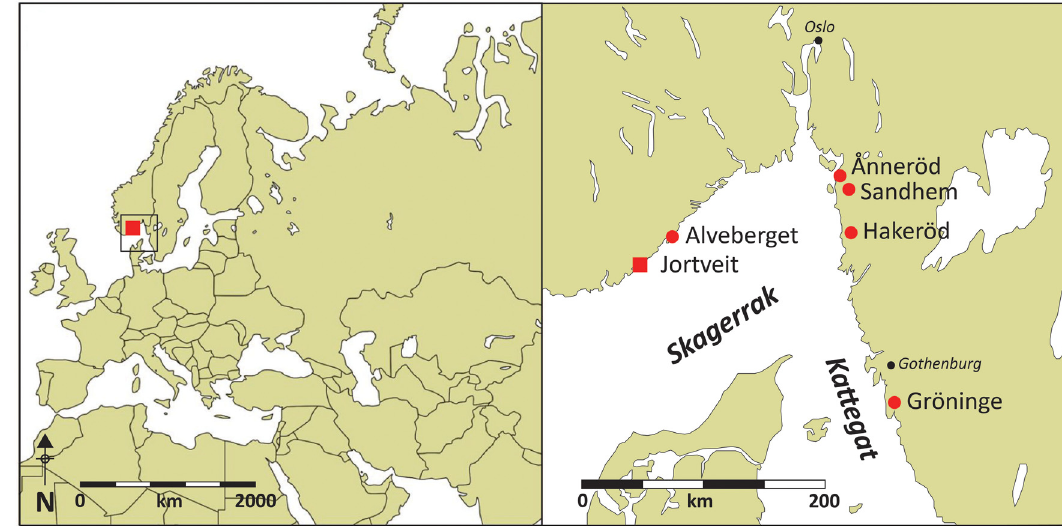
Figure 1: Left: Map of Europe with the Skagerrak Coast region ( black box ) , and the location of the site Jortveit ( red square ) . Right: The Neolithic occupation sites in Norway and Sweden with evidence of Blue fi n tuna consumption discussed in the text. Figure by Svein V.